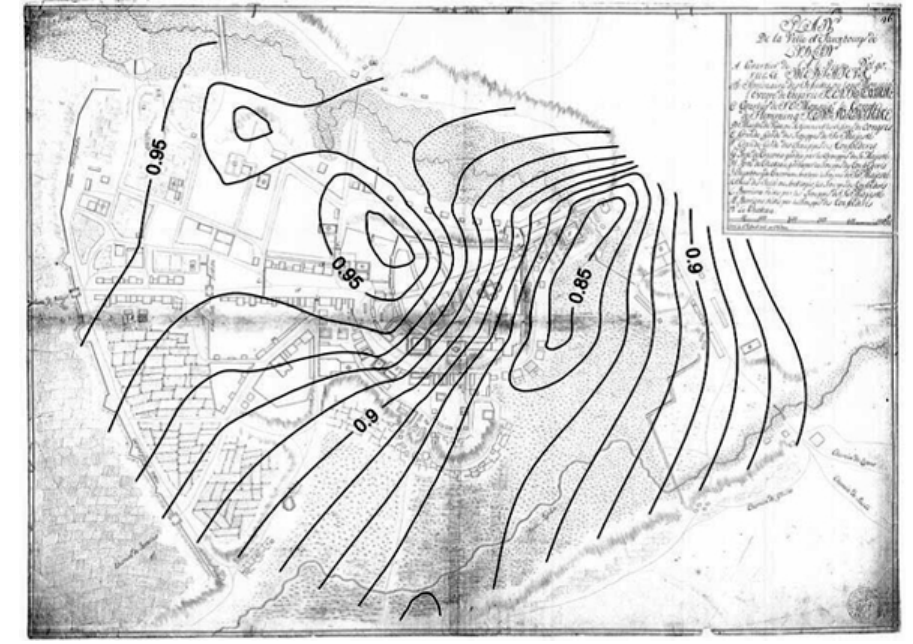
Fig. 2. Isolines of the correlation coefficient (source: K. Nieścioruk 2007)